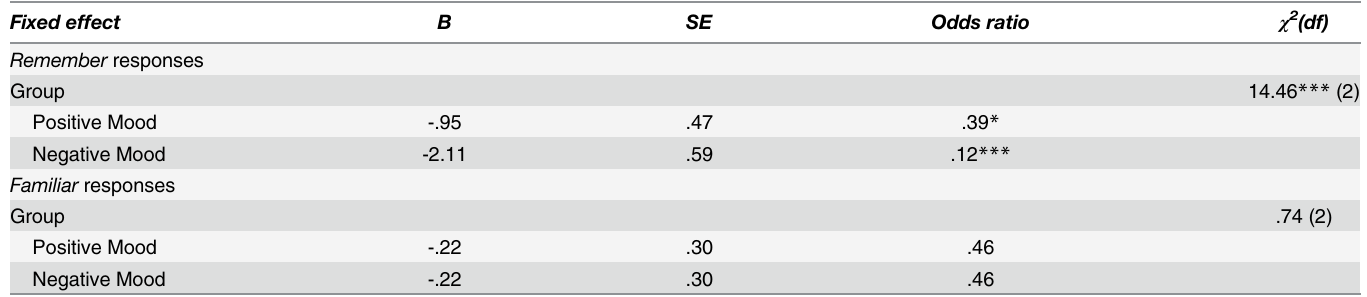
Table 3. Fixed effect of Group on remember and familiar responses associated with Causal